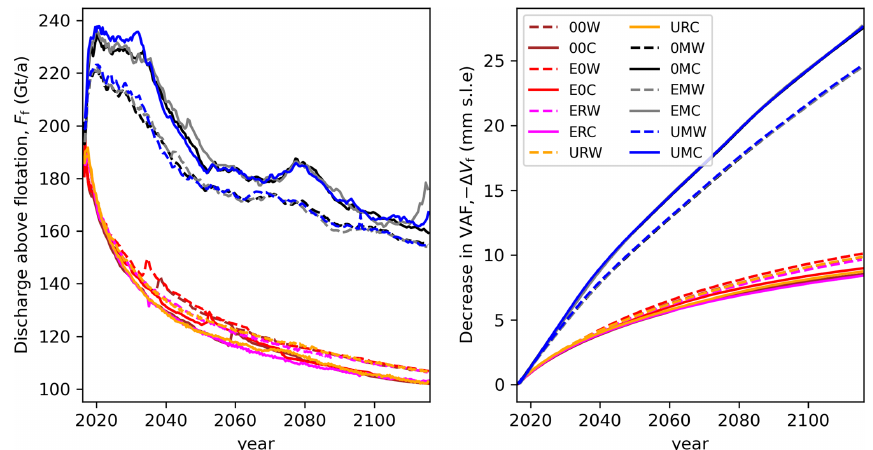
Figure 12. Discharge of ice above flotation F f and change in volume above flotation (VAF), (cid:49)V f associated with modelled changes to TEIS. Colours and line styles are grouped according to melt forcing and friction parameterisation. Dark (blue/grey/black) lines show the results of simulations with sustained future melting, bright lines (red, orange, purple) show the results of simulations without sustained future melting. Solid lines represent simulations with Coulomb-like friction and dashed lines show Weertman-like